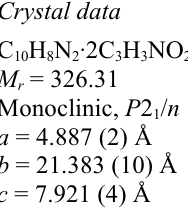
View of the π - π interactions between bipyridine rings in the crystal structure of the title compound. 4,4 ′ -Bipyridine–cyanoacetic acid (1/2) Crystal